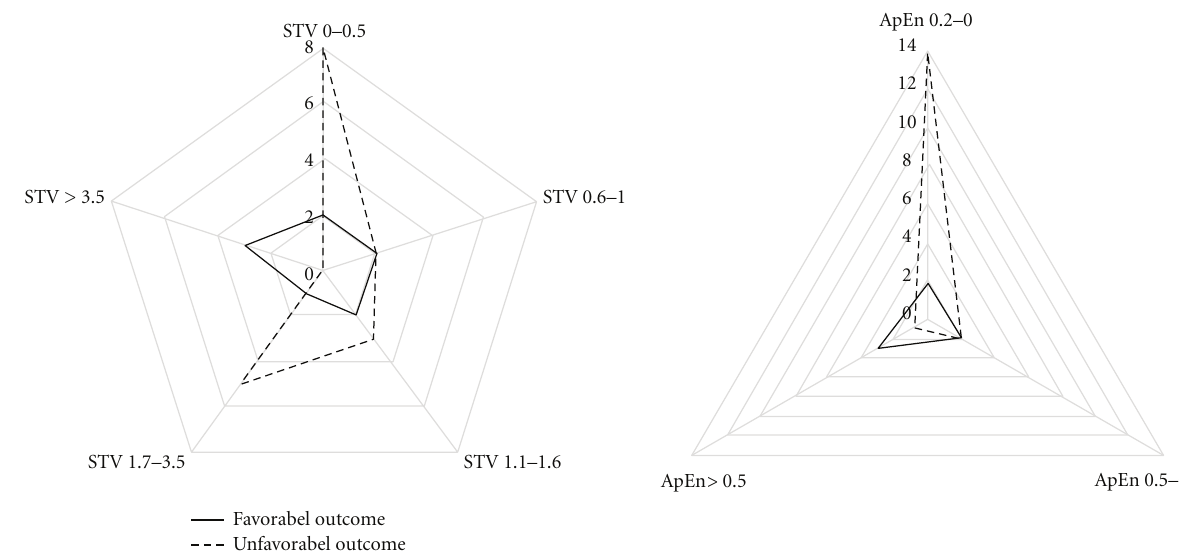
Figure 2: Radar graph representing the cuto ff values found for short term variability (STV) and approximate entropy